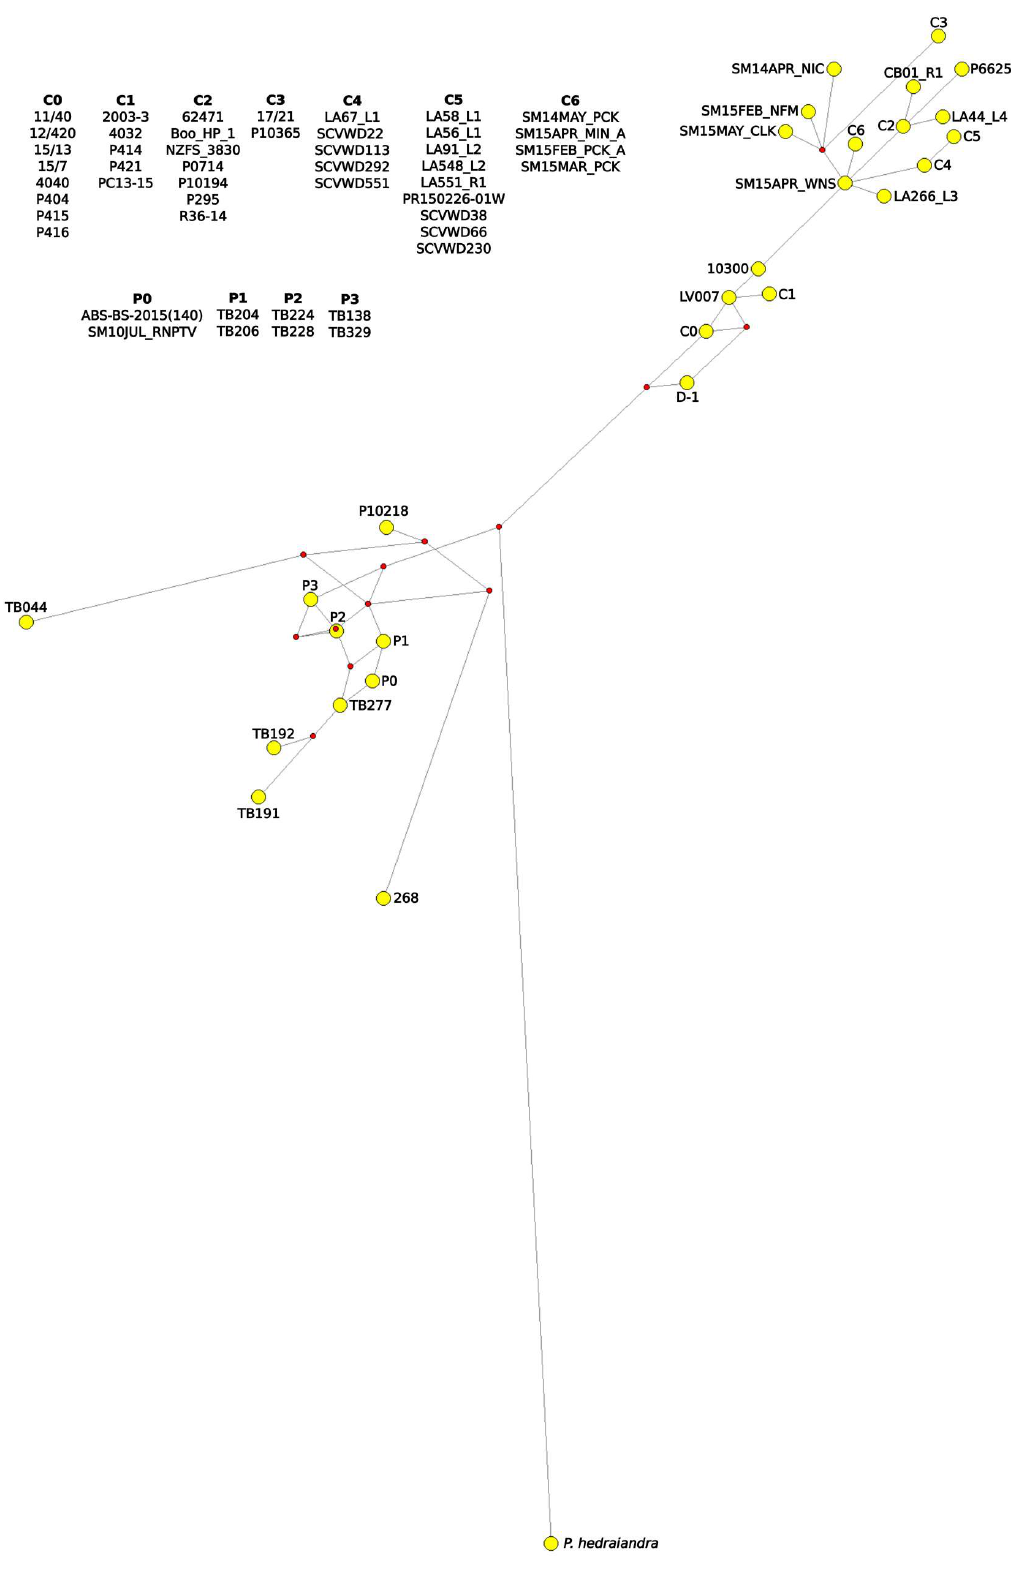
Figure 6. Median-joining network from mitochondrial cox2+cox1 loci of Phytophthora cactorum and P. pseudotsugae , tolerance ε = 0. Accession information listed in Table S1. Figure created with Network 10 and annotated with InkScape. Yellow circles represent isolates or groups of isolates with identical sequences, and red diamonds represent unsampled intermediates.